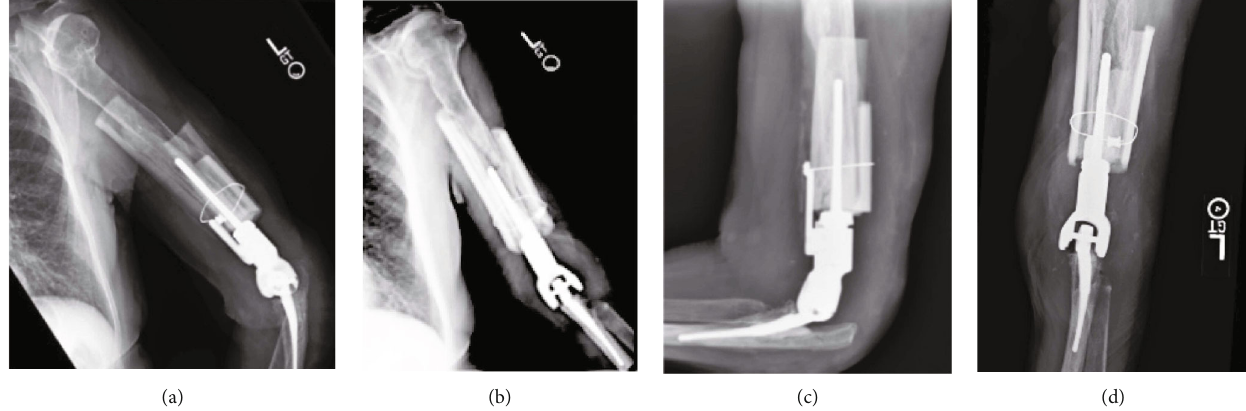
Figure 6: (a – d) 12-month postoperative X-ray images: (a) lateral humerus X-ray; (b) AP humeral X-ray; (c) lateral elbow X-ray; (d) AP elbow